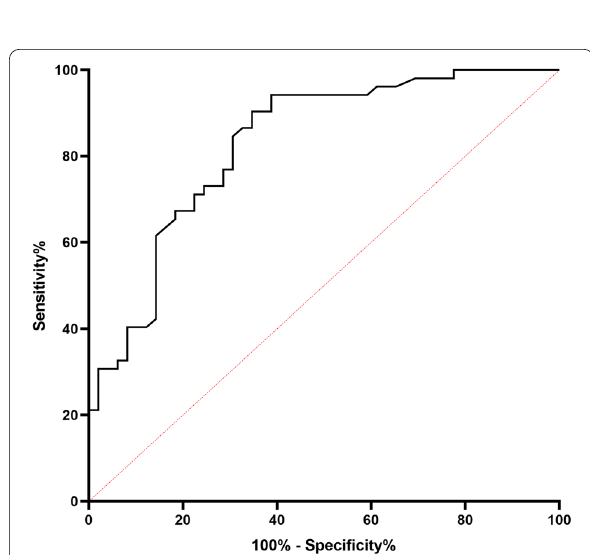
Fig. 5 ROC curve of the SUVmax for high‑risk prostate cancers.